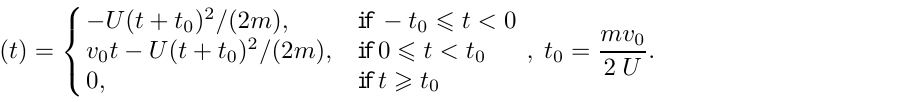
Fig. 5. Time history of the relative velocity of the object corresponding to the constant force pre-acting